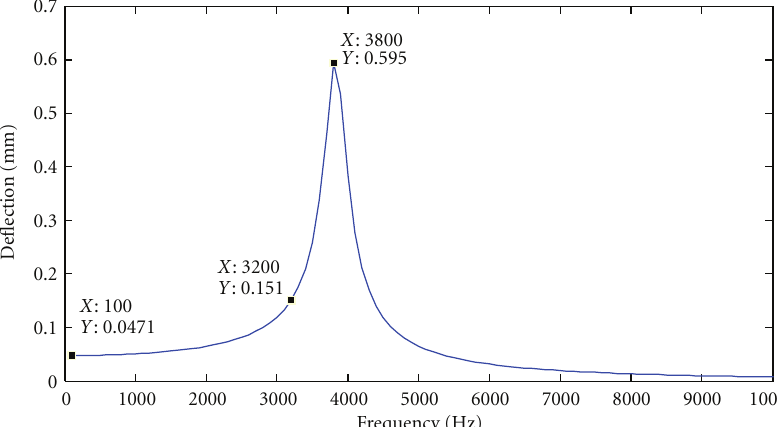
0 Figure 9: Harmonic response linear total maximum deflection for a 1000 Pa pressure acting on one surface of the